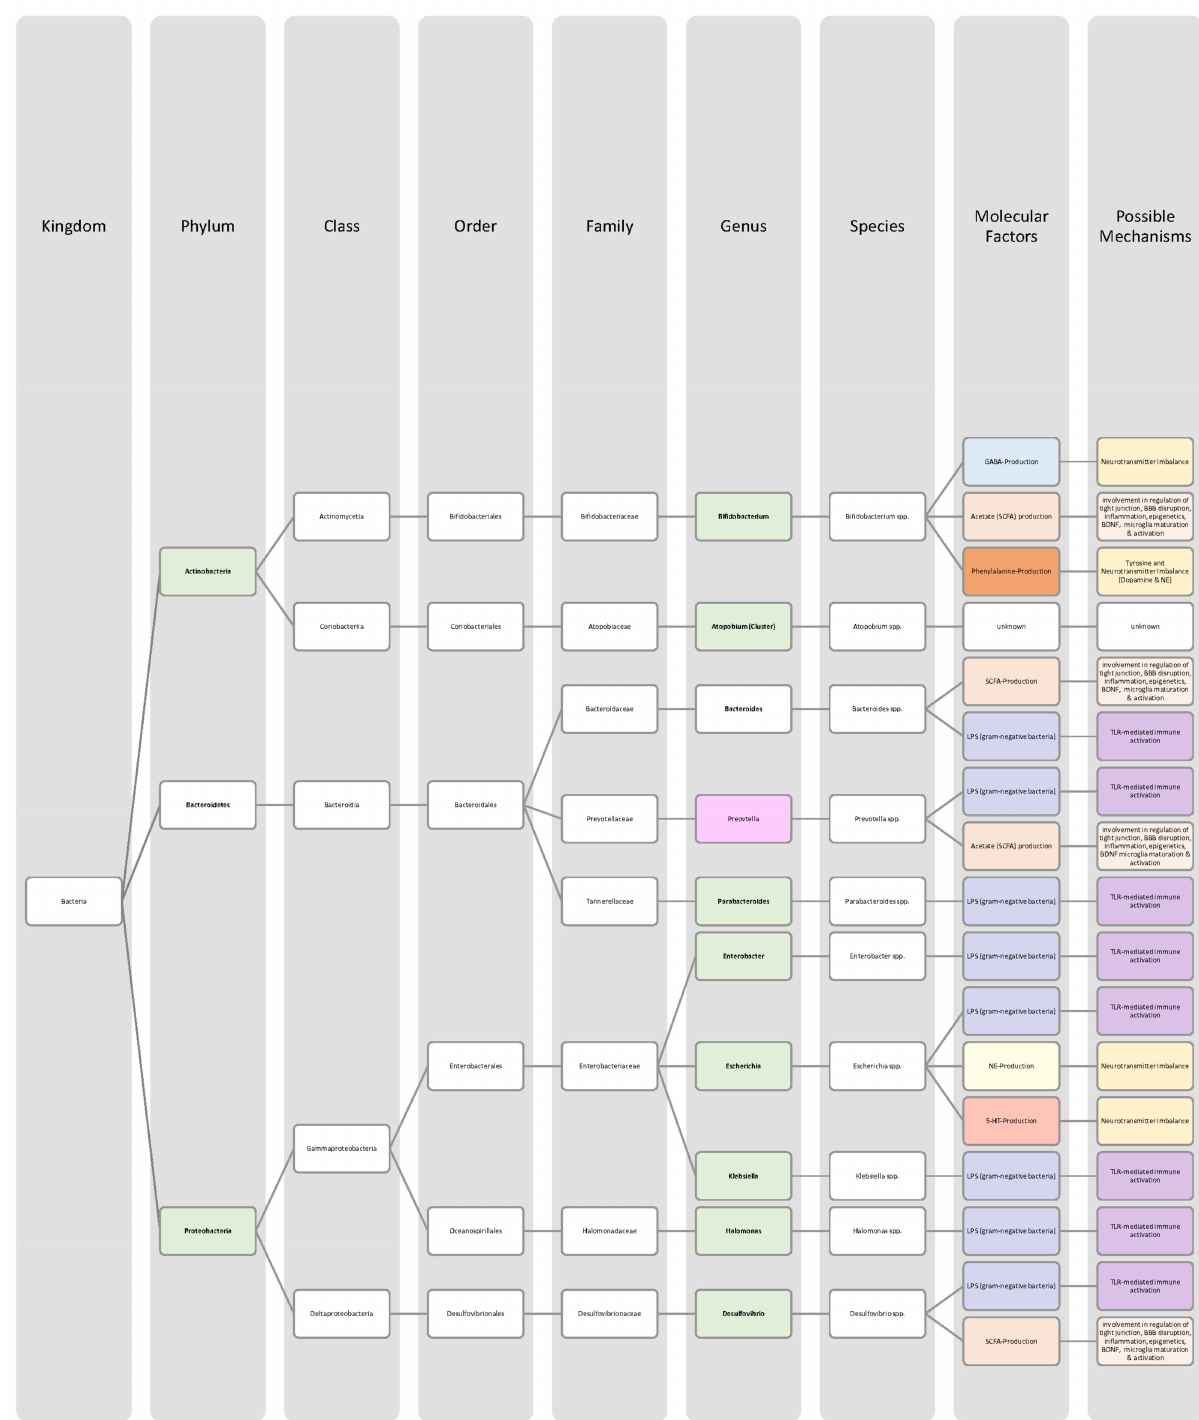
Figure 12. Part 1 of visual representation of the changes in microbiota composition in bipolar disorder (BD) patients from Table 8. For an explanation, see the legend of Part 2 in Figure